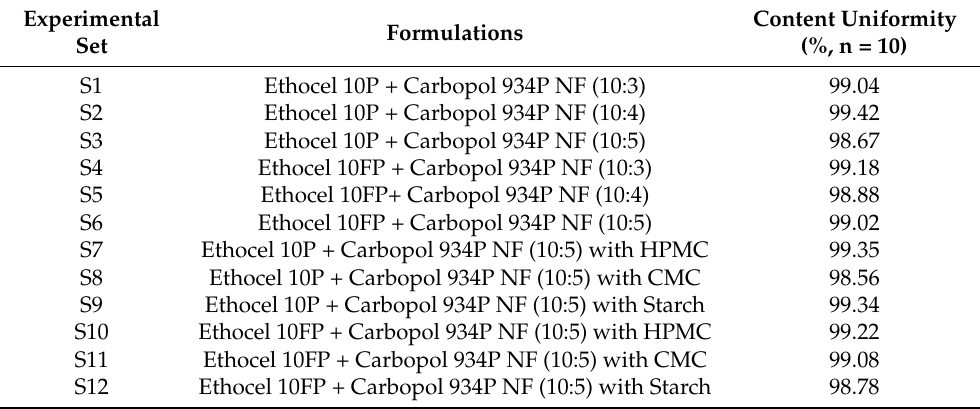
Table 4. Content uniformity of the sets of